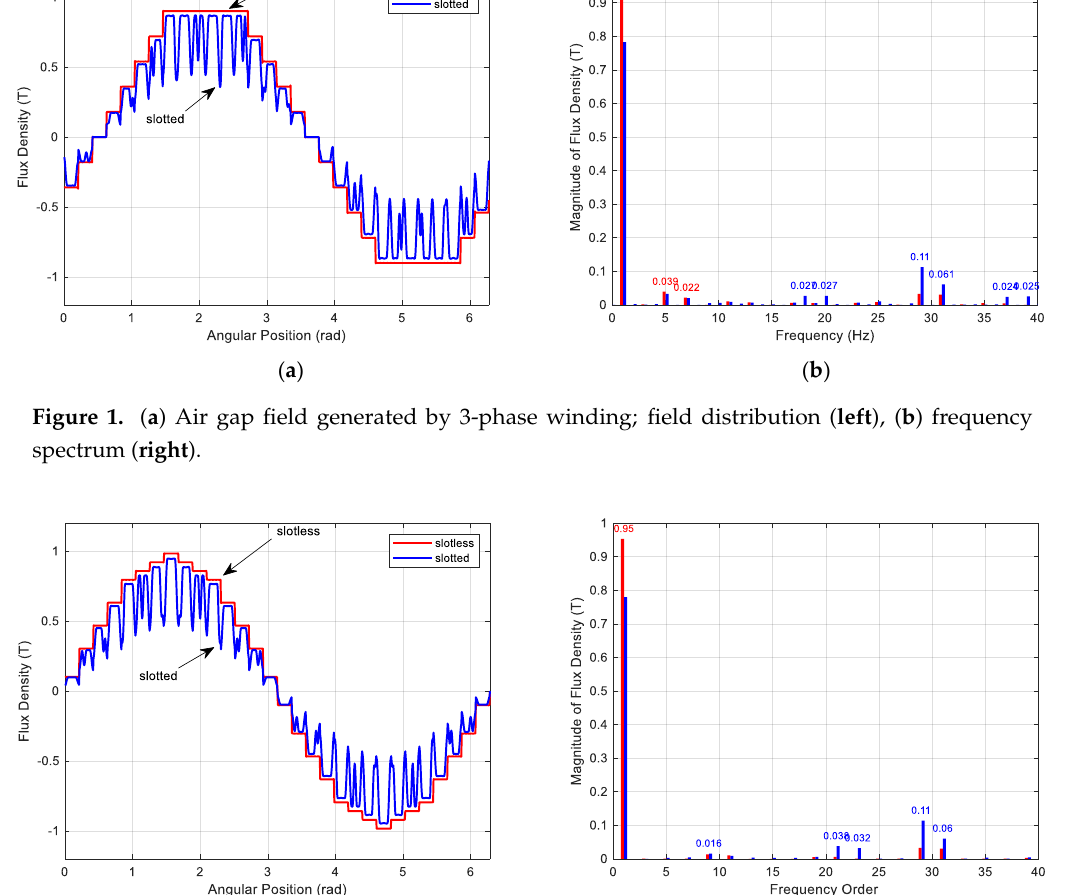
Figure 2. ( a ) Air gap field generated by 5-phase winding; field distribution ( left ), ( b ) frequency spectrum ( right ).